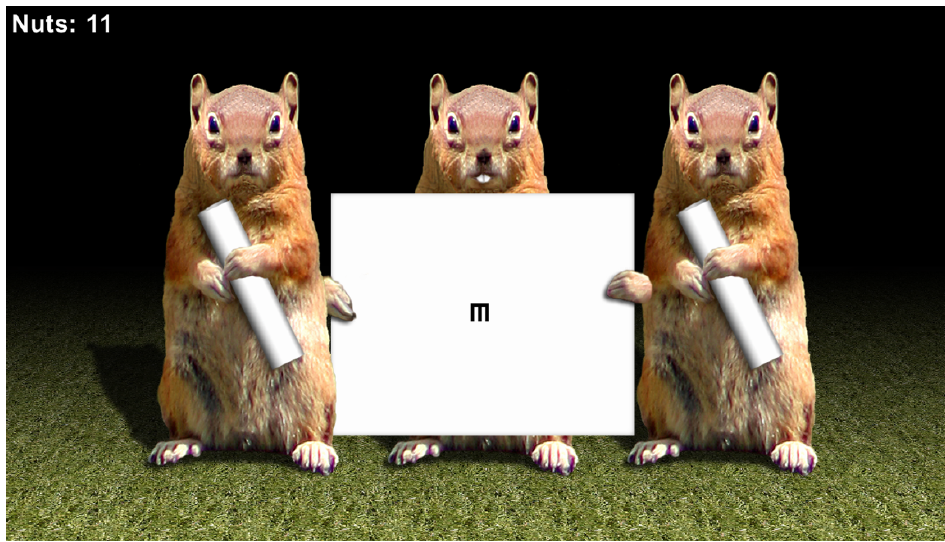
Figure 1. Game called “Chipmunk chase” based on orientation discrimination with Snellen E optotypes .